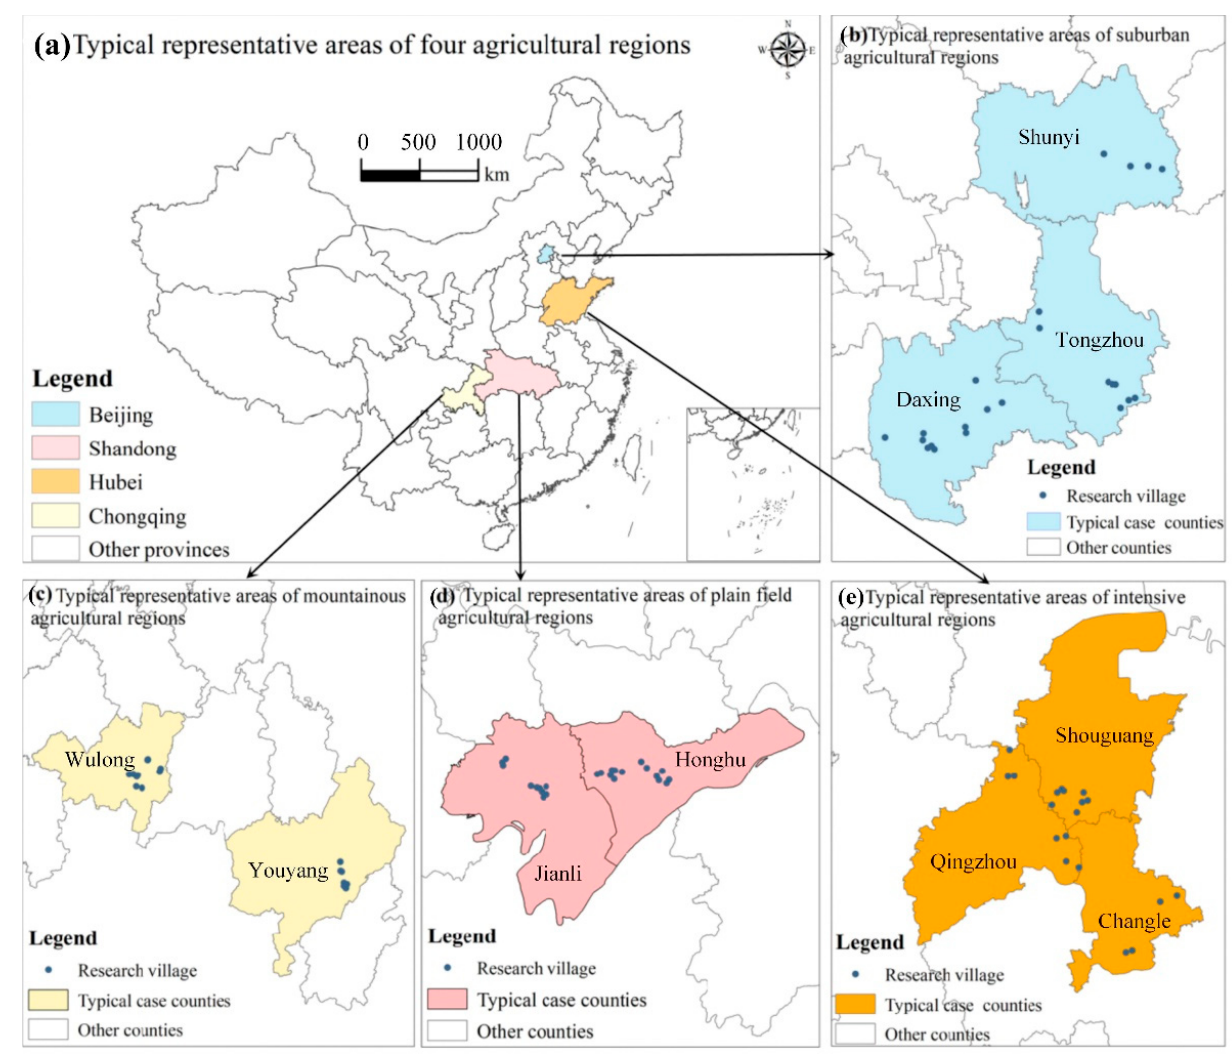
Figure 1. Geographical location of the study areas.